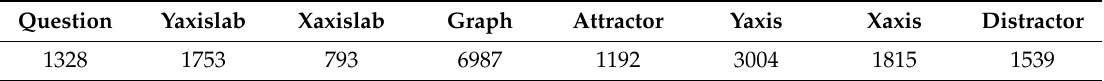
Table 2. Sum of transitions per single